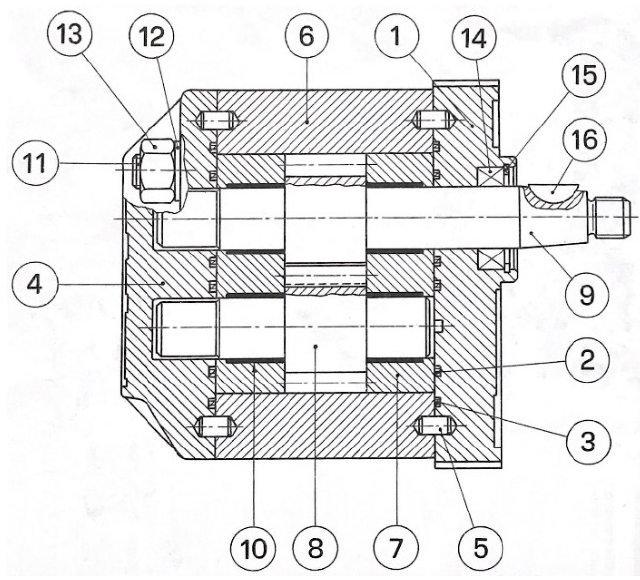
Figure 3. 2D drawing of the hydraulic external gear pump.